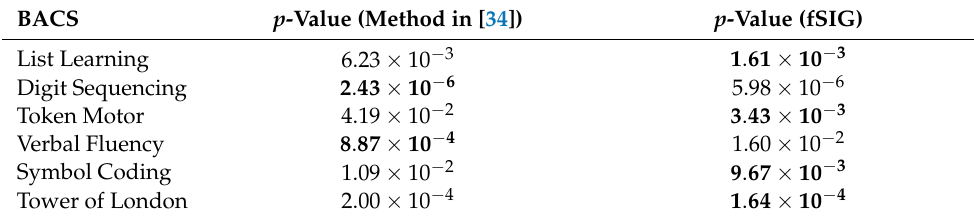
Table 2. Two-sample t -test of each test included in BACS (lower p -value is marked in bold).